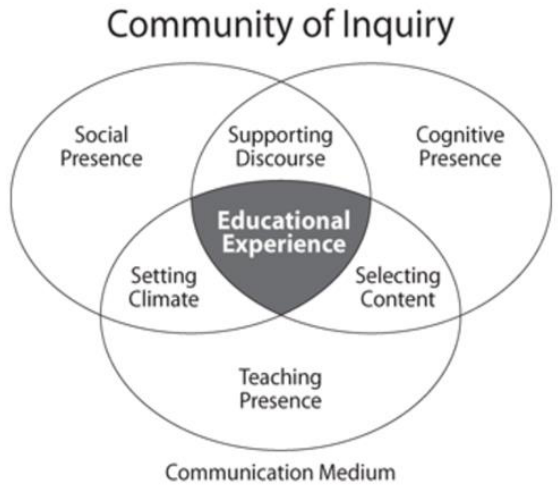
Figure 1: Community of Inquiry Framework (Garrison et al.,